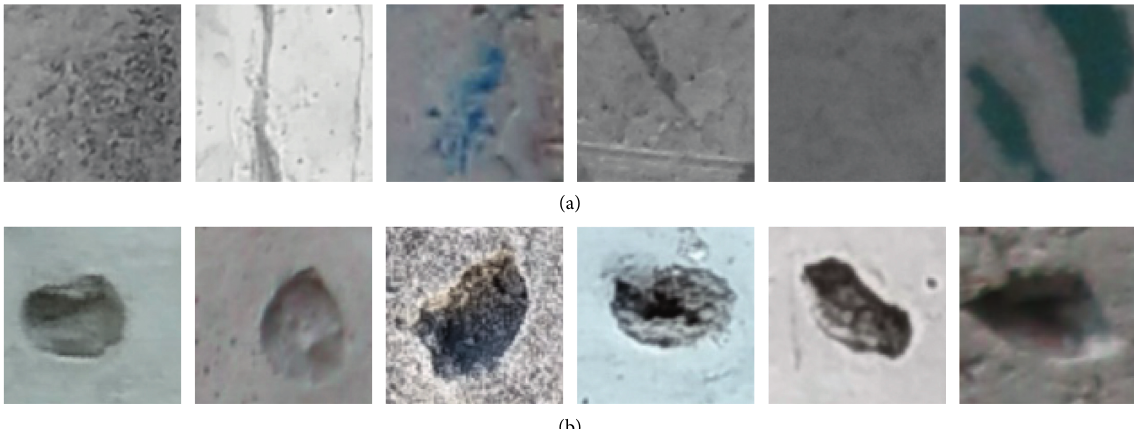
Figure 4: The collected image samples: (a) nonsurface void and (b) surface void.